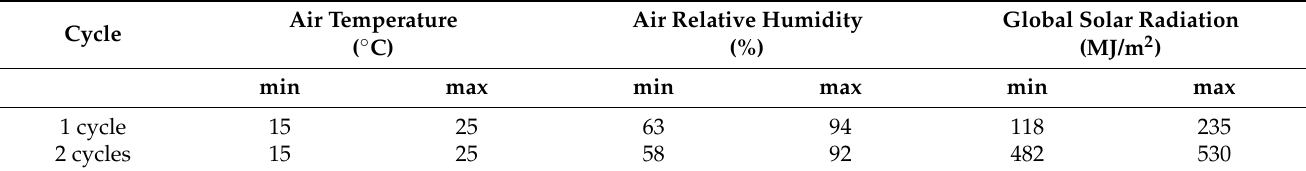
Table 1. Maximum and minimum values of the main climatic parameters during the crop cycles in the